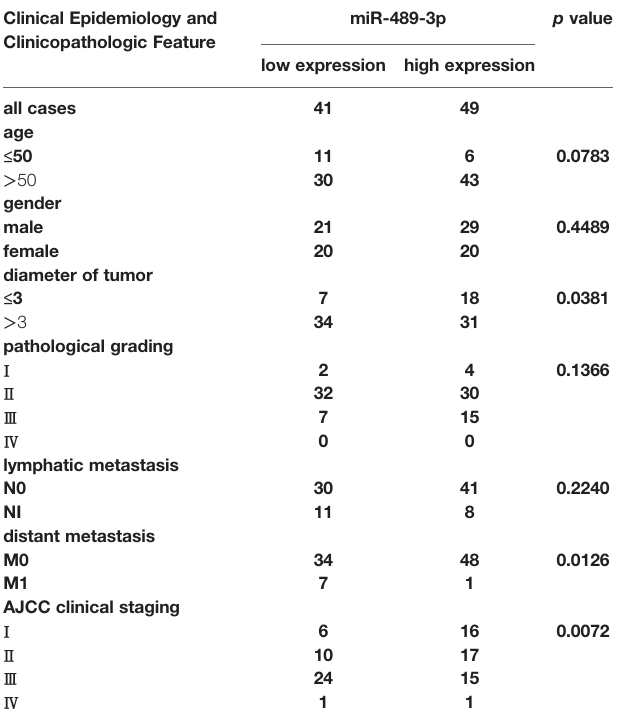
TABLE 1 | Association of miR-489-3p expression with clinicopathological features from PC patients. Clinical Epidemiology and Clinicopathologic